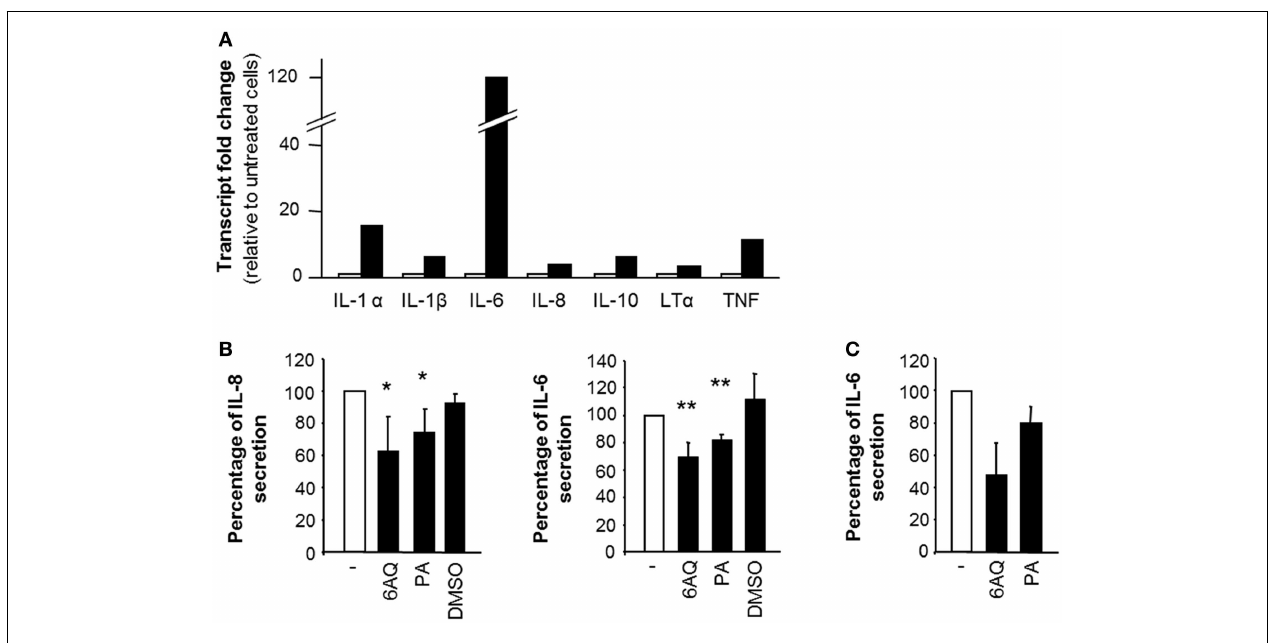
(B) 300 µ g/ml STBM-NP or (C) 100pg/ml LPS. After 16h of incubation, cytokine secretion was measured by ELISA and reported as a percentage of secretion relative to that of monocytes stimulated by STBM-NP in the absence of any drug. Data are presented as mean ± SEM of three independent co-culture experiments with four STBM-NP preparations. * p < 0.05; ** p < 0.01. LPS was used as a positive